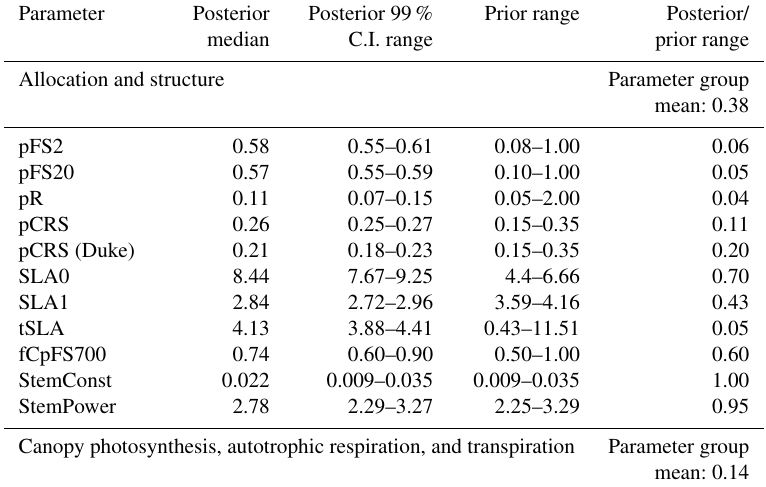
Table 5. The optimized medians, range of the 99% quantile intervals of the posterior distributions and the 99% quantile range for priors with normally distributed priors or the range of the upper and lower bounds for priors with uniform distributions. C.I.: credible